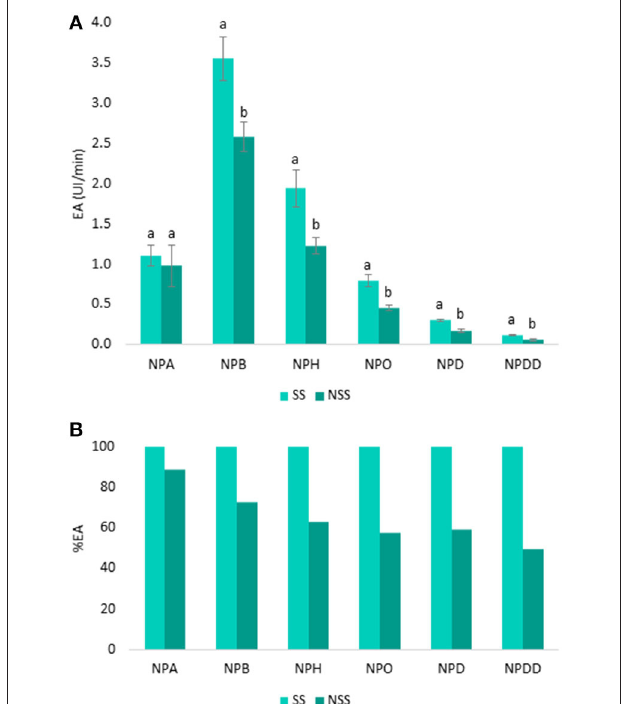
FIGURE 2 | Specificity of the esterase activity in UI/min in stimulated saliva (SS) and non-stimulated saliva (NSS) toward six p-NP-esters: p-NP-acetate (NPA), p-NP-butyrate (NPB), p-NP-hexanoate (NPH), p-NP-octanoate (NPO), p-NP-decanoate (NPD), and p-NP-dodecanoate (NPDD) (A) . Letters above the bars denote significant differences ( p < 0.05) between SS and NSS from Tukey’s test. In (B) , the EA from SS was considered as 100%, the EA percentage from NSS was then